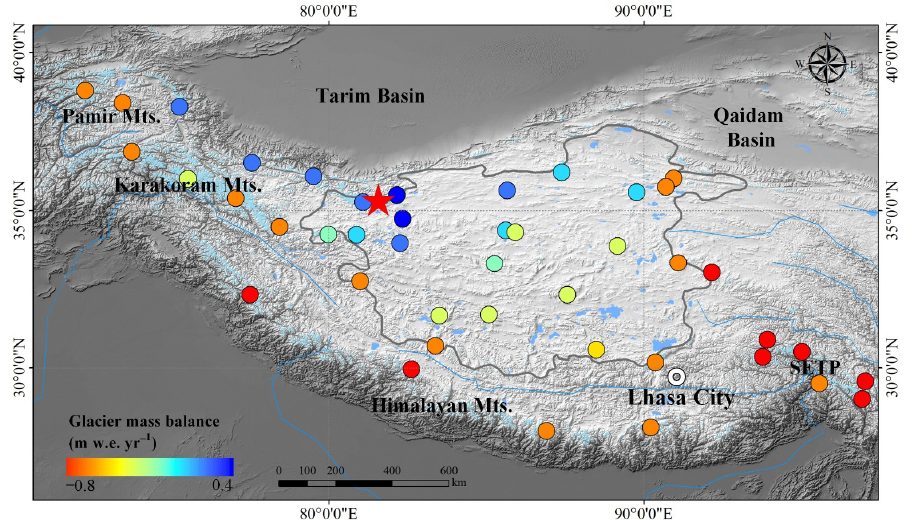
Figure 11. Our measured results of the INTP and the previously published geodetic estimates in the Pamir, Karakoram, Himalaya Mts. and southeastern TP (SETP). The red star, which is located at the western Kunlun Mts., represents the possible center of glacier anomalous regions which is estimated with a visual interpretation.